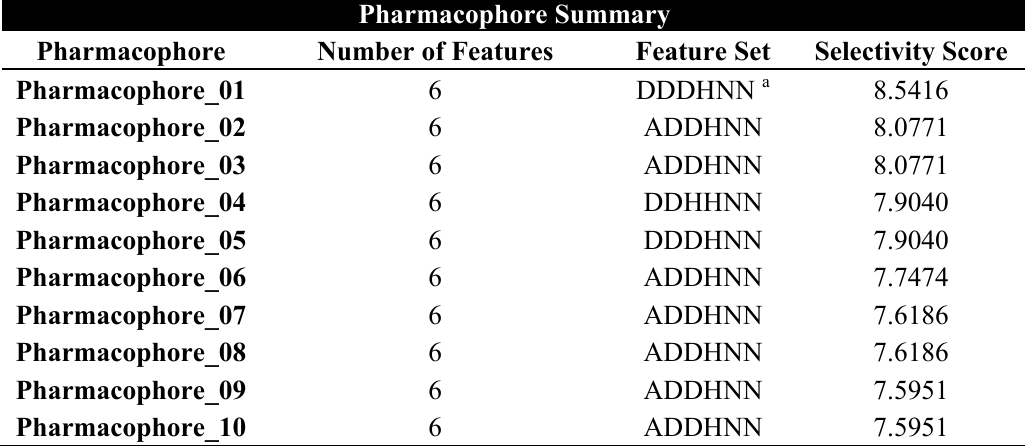
Table 1. The generated pharmacophore models with their selectivity scores based on Glo-1 enzyme bound to its ligand.